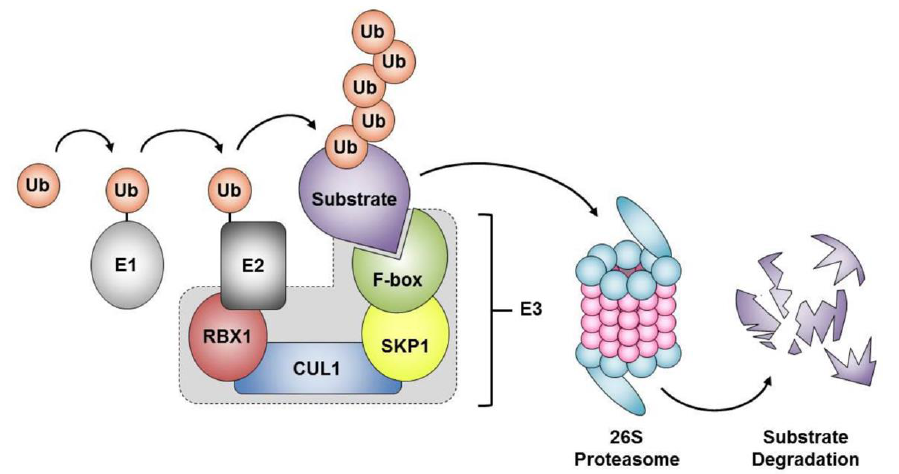
Figure 2. The SCF complex orchestrates proteolytic degradation by the 26S proteasome. Schematic of the SCF complex consisting of four components, including invariant core members (SKP1, RBX1 and CUL1) and one of the 69 variable F-box proteins. The F-box proteins facilitate the transfer of ubiquitin from the E2-conjugating enzymes onto protein substrates, where poly-ubiquitination often denotes those targeted for proteolytic degradation via the 26S proteasome. E1, E1 ubiquitin-activating enzyme; E2, E2 ubiquitin-conjugating enzyme; E3, E3 ubiquitin-protein ligase; Ub, Ubiquitin.